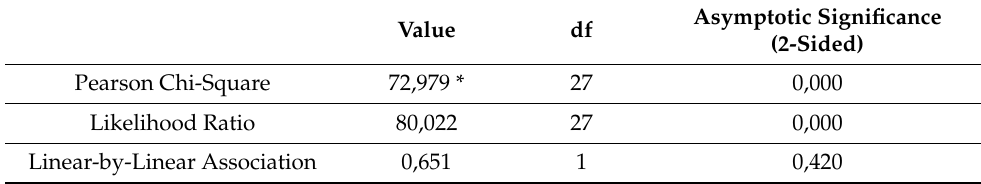
Table 3. Chi-Square Test